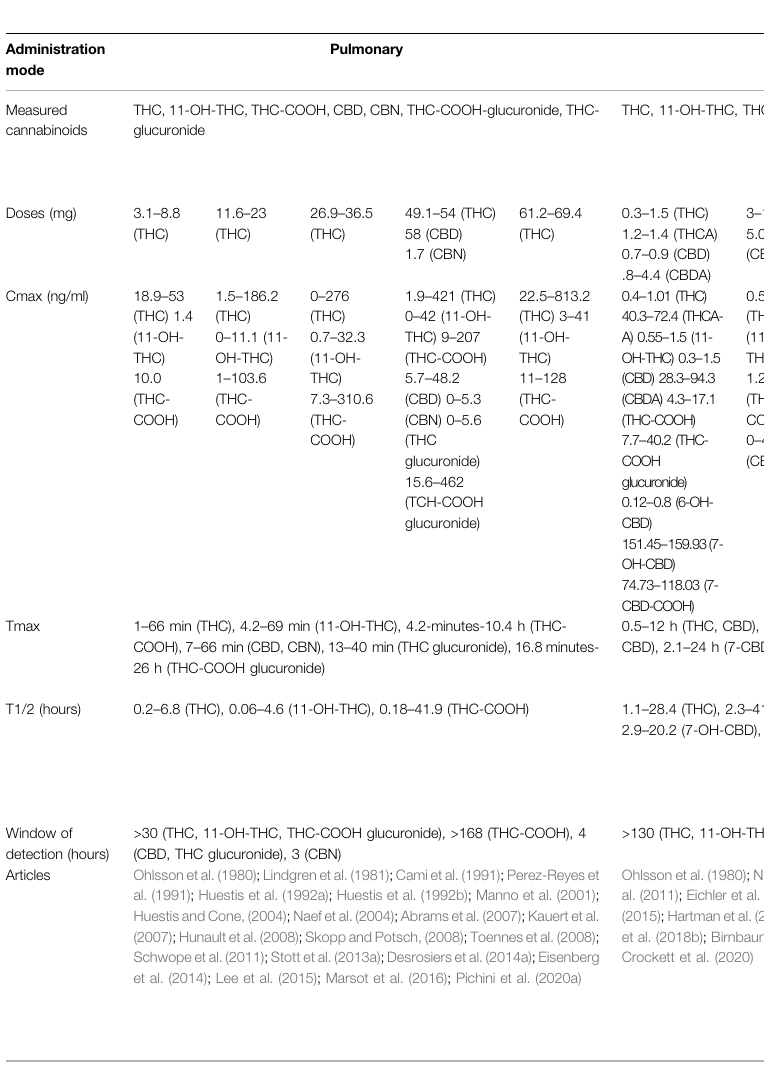
TABLE 1 | Pharmacokinetics of cannabinoids in the general